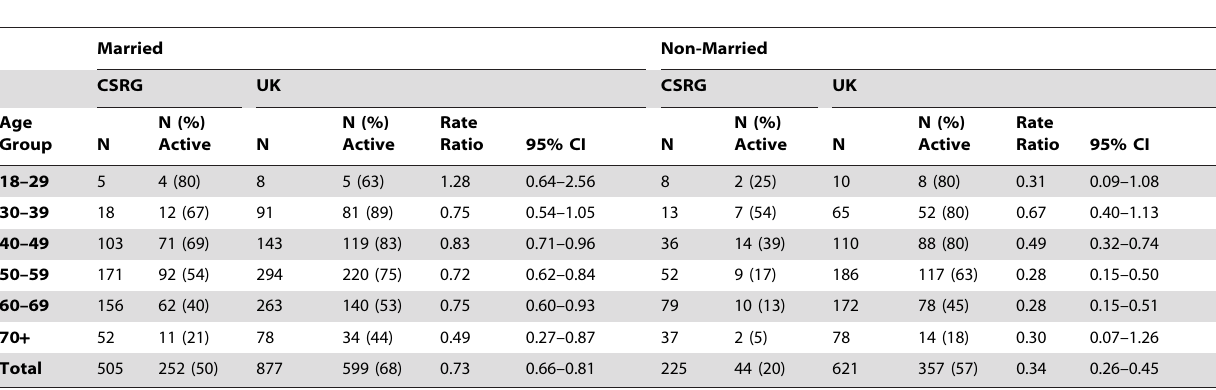
Table 2. Comparison of sexual activity rates between women with systemic sclerosis and women from a UK general population sample, stratified by age and marital status.